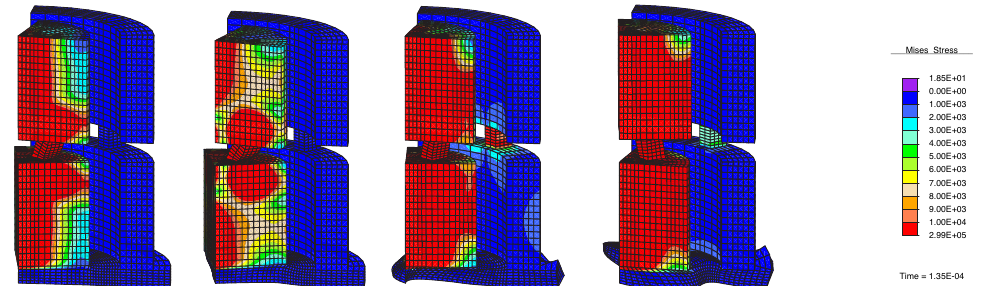
Figure 2. Torsional transducer at instants t = 9, 18, 117, 135 µ s. Tissue is the